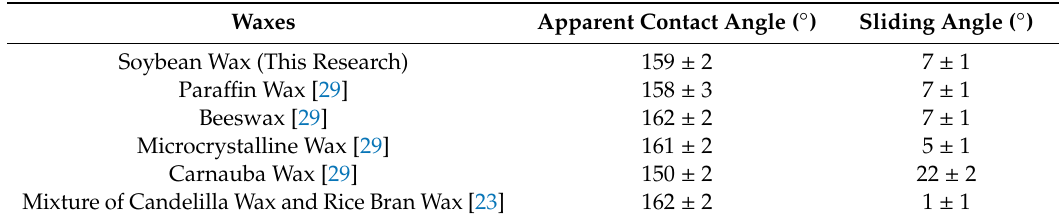
Table 1. The apparent contact angle and sliding angle of the superhydrophobic coatings with different waxes. Waxes Apparent Contact Angle (°) Sliding Angle (°)